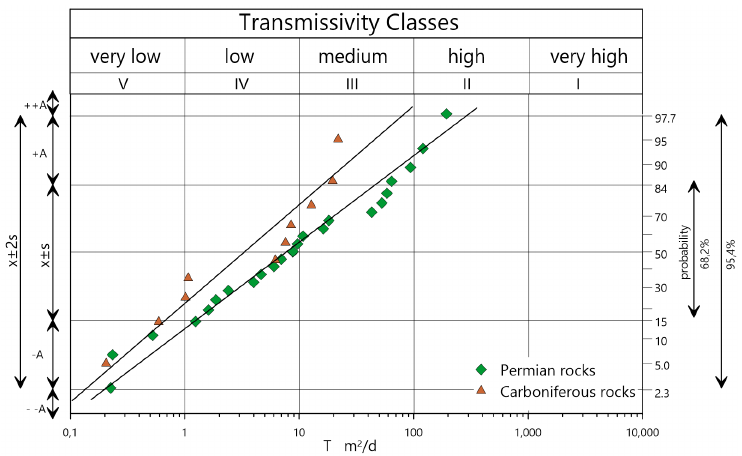
Figure 6. Water transmissivity classes for selected aquifers [34]. T—transmissivity, x ± s—mean ± standard deviation, x ± 2s—mean ± 2 times standard deviation. Transmissivity classes based on